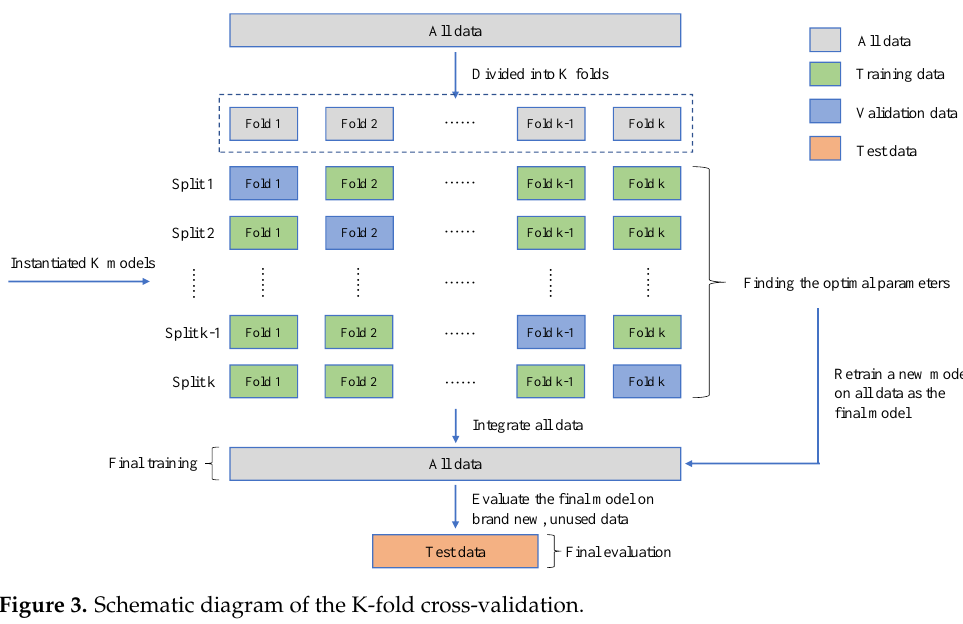
Figure 3. Schematic diagram of the K-fold cross-validation.